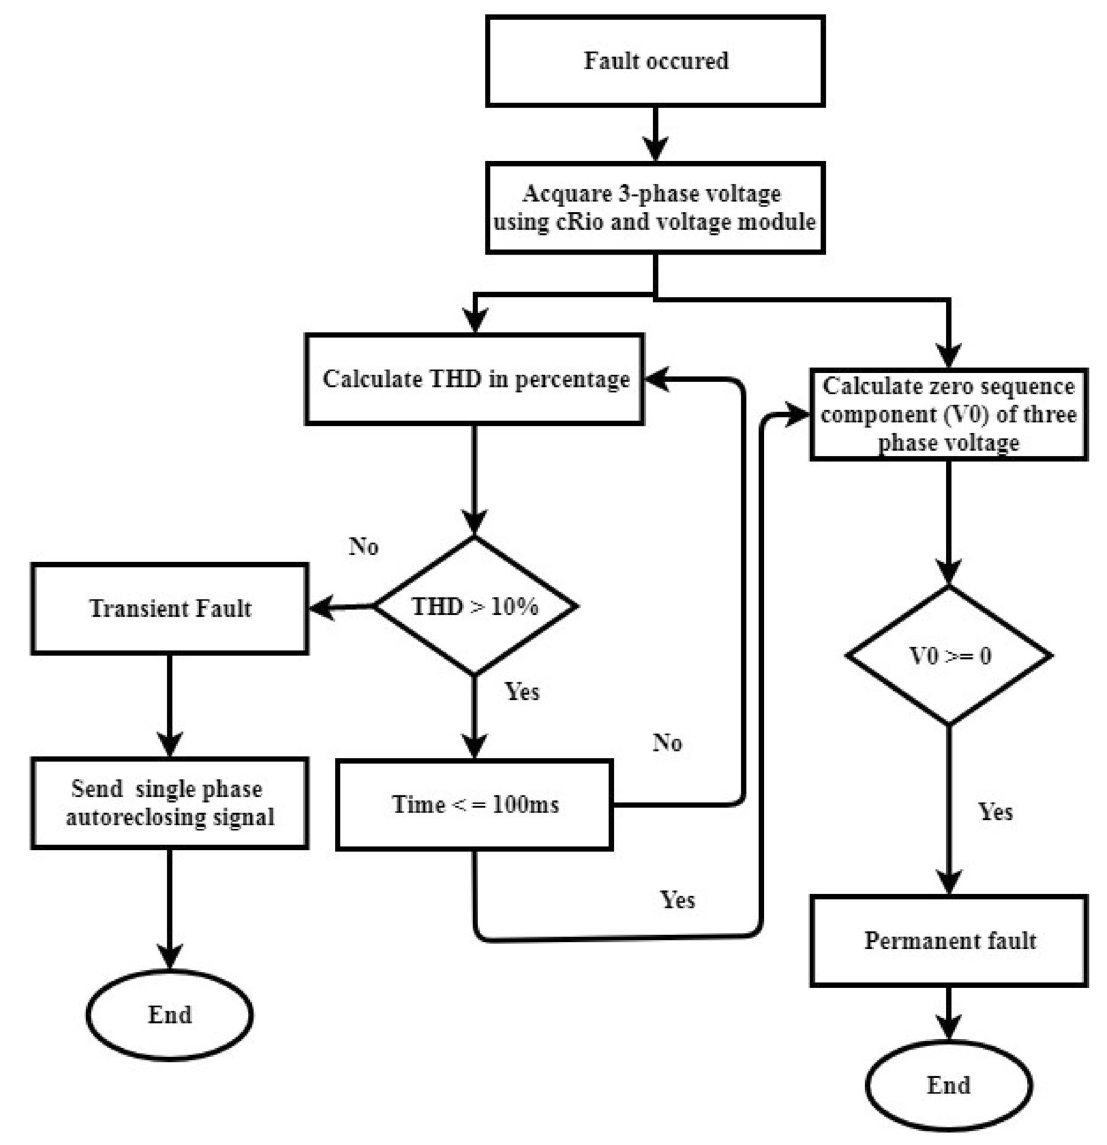
Fig. 8 Proposed flowchart for auto-reclosing